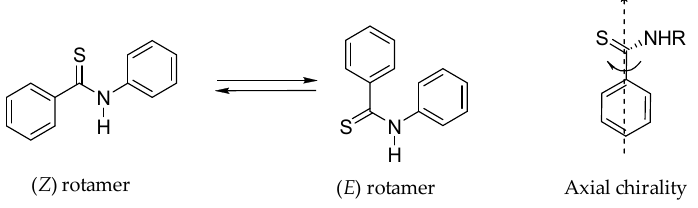
Figure 4. ( Z ) and ( E ) rotamers and axial chirality for thiobenzanilides .